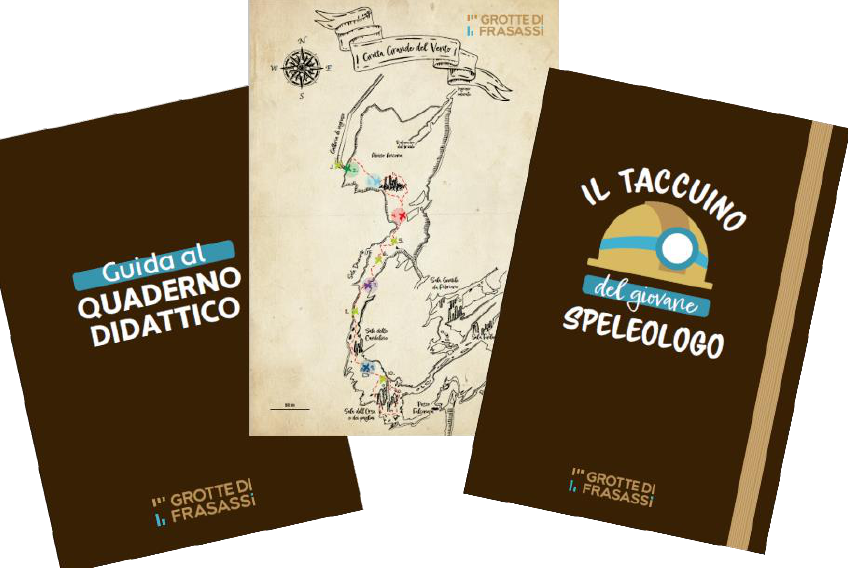
Figure 3. The two notebooks (one for teachers and guides and the other for students) with the map of the cave and the real scenario for the